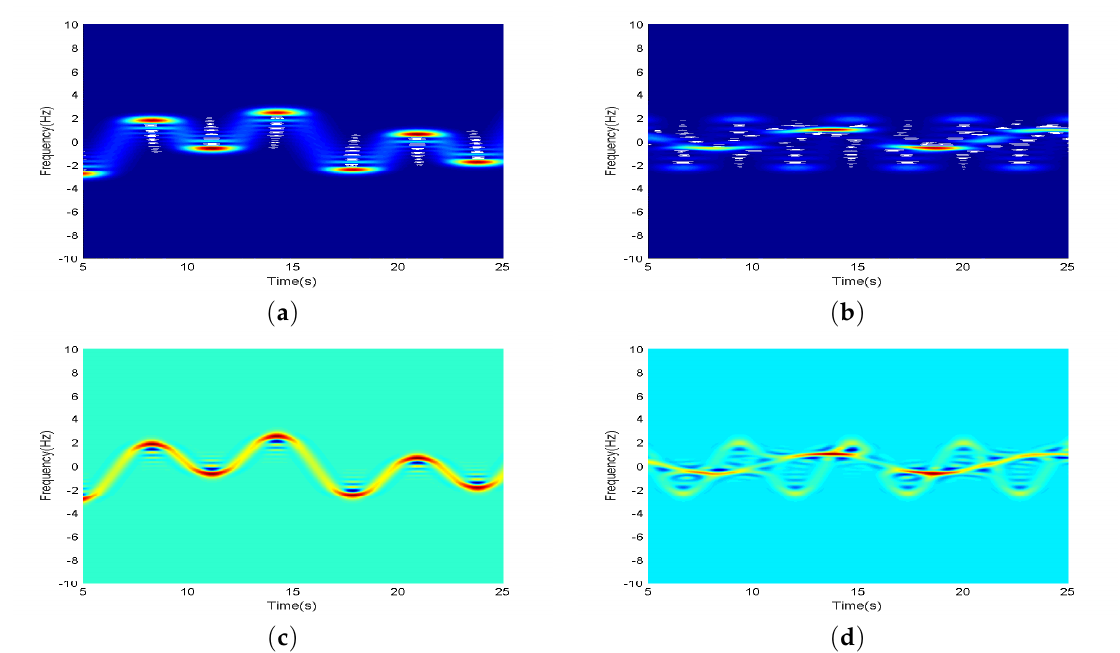
Figure 2. ( a ) is original mono-component signals; ( b ) is original multi-component signals; ( c ) is multiwindow processing results of mono-component signals; ( d ) is multiwindow processing results of multi-component